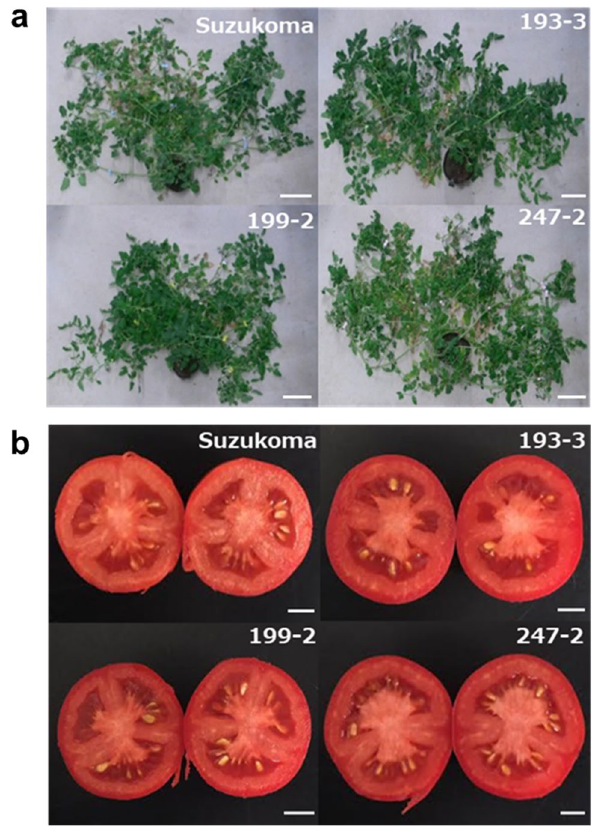
Figure 3. Phenotypes of the SlINVNH1 genome edited lines. ( a ) Visual vegetative phenotype of original cultivar ‘Suzukoma’ and the SlINVINH1 genome edited lines (193–3, 199–2, and 247–2). Scale bar = 15 cm. ( b ) Fruits at mature stage from ‘Suzukoma’ and the SlINVINH1 genome edited lines. Scale bar = 1